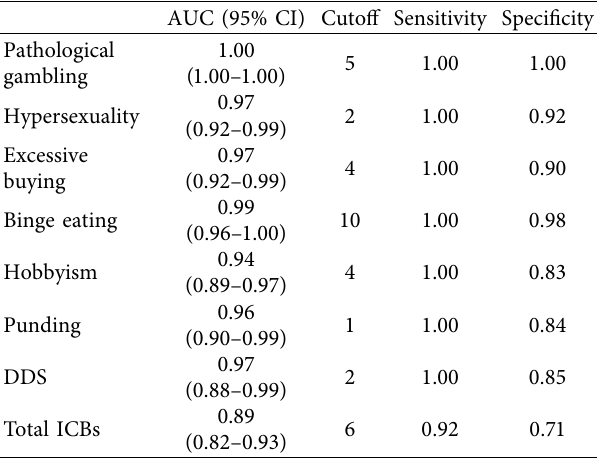
Figure 2: Receiver-operator characteristics (ROC) curve from the diagnosis of ICBs versus QUIP-RS score. The optimal cutoff value was 6, with a sensitivity of 0.92 and a specificity of 0.71. Area under the curve (AUC) was Table 2: AUC, cutoff, sensitivities, and specificities for the QUIP- RS score.